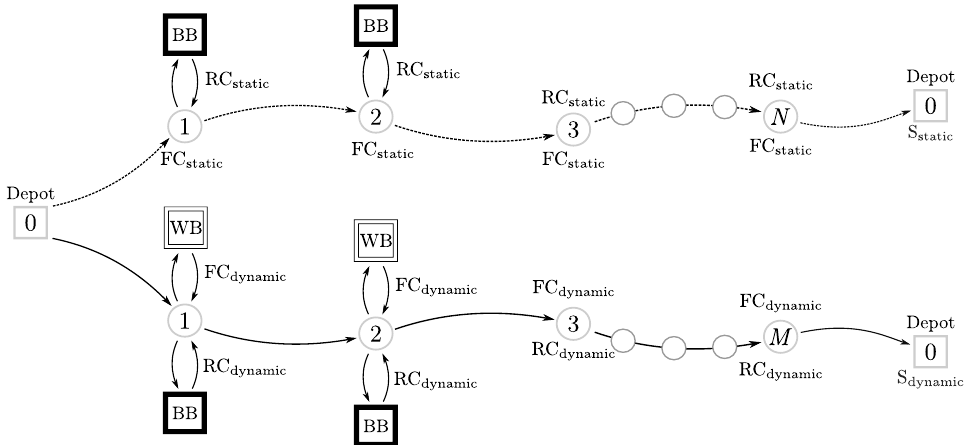
Figure 1. Diagram of the learnheuristics methodology applied to construct a single solution for the